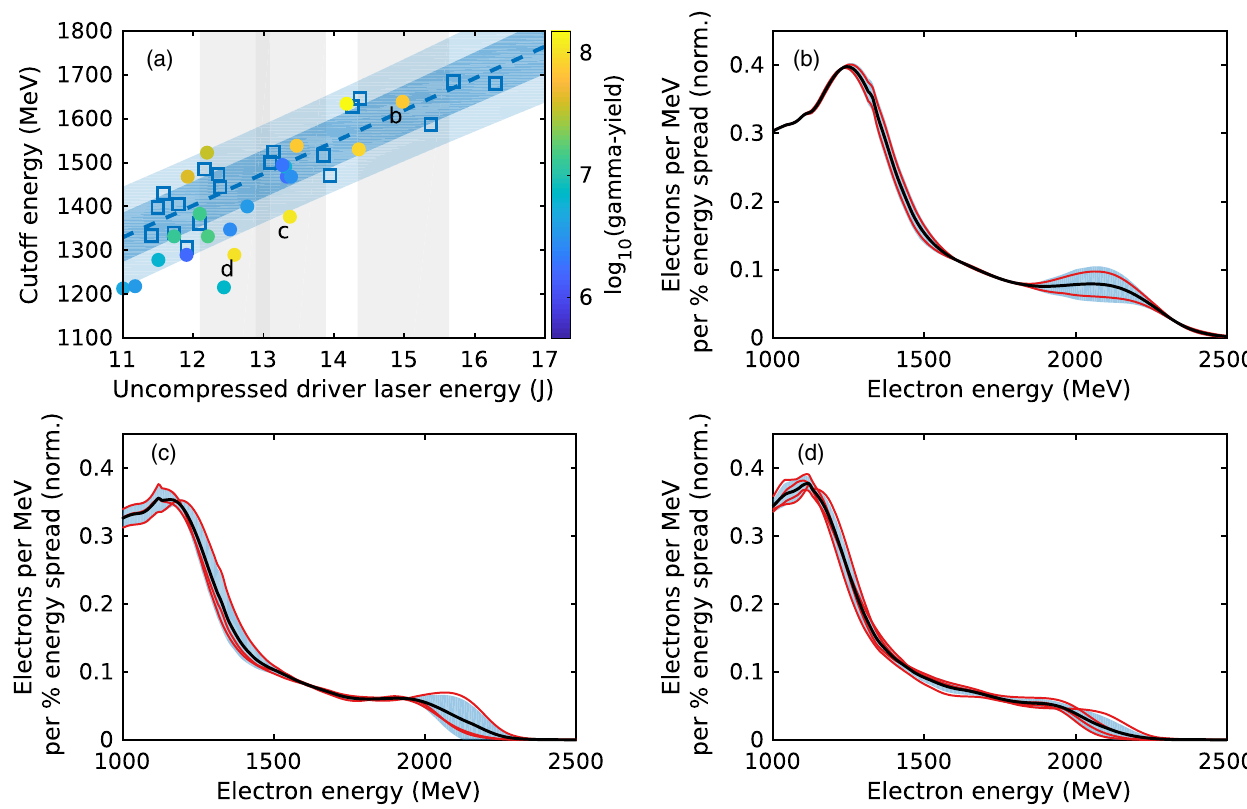
FIG. 2. Reference electron spectra. (a) Cutoff energy of the electron beam for shots with the scattering laser off (reference shots, empty squares) and on (color-coded circles). The dashed blue line represents a linear fit ( R 2 ¼ 0 . 85 ) for the reference shots with the lighter and darker blue bands representing regions of 95% and 68% confidence, respectively. The circles are colored according to the recorded total energy of the emitted photon beam (colorbar on the right, arbitrary units). The shots analyzed in the manuscript showing strong (d), weak (c), and negligible (b) radiation reaction are also labeled. The grey bands represent regions from where the reference shots for each of the analyzed shots have been selected. (b) Initial electron spectra (scattering laser off) for a laser energy between 14.2 and 15.7 J. (c) Initial electron spectra (scattering laser off) for a laser energy between 12.9 and 13.9 J. (d) Initial electron spectra (scattering laser off) for a laser energy between 12.1 and 13.1 J. In frames (b) – (d), thin red lines represent single shots, thick black lines represent an average, and the associated bands represent one standard